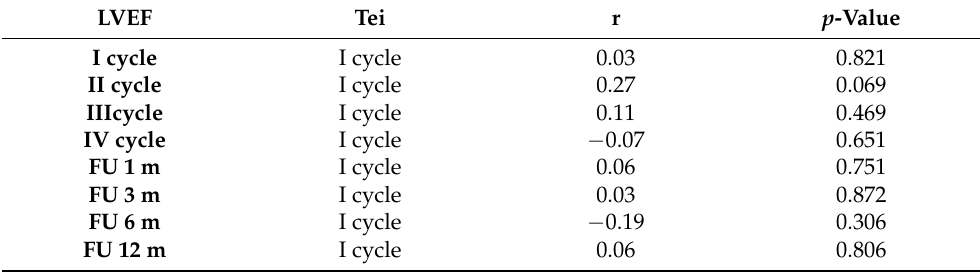
Table 3. Correlation between left ventricular ejection function (LVEF) during chemotherapy and follow-up and basal Tei index